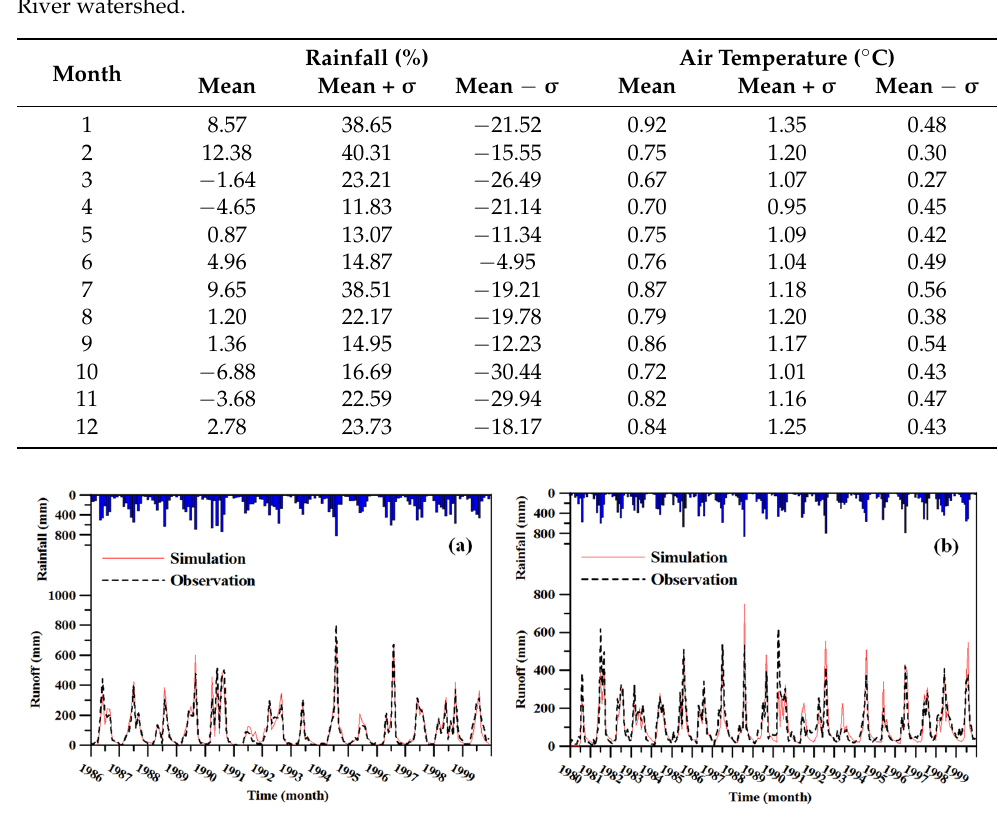
Figure 9. Comparison of simulation and observation results of river discharge in ( a ) the Choushui River, and ( b ) Beigang River catchments. Table 6. Parameter calibration results for the modified HBV model in the Choushui River alluvial fan. FC β Catchment